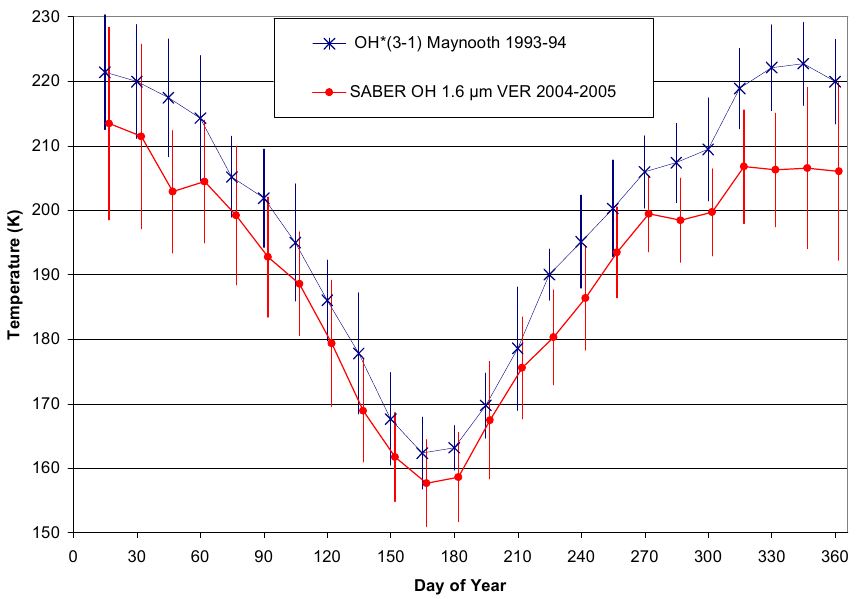
Fig. 10. OH*(3-1) rotational temperatures recorded at Maynooth in 1993 and 1994 together with OH-equivalent temperatures calculated from SABER temperature profiles at Maynooth in 2004 and 2005 using the SABER OH 1.6 µ m VER profile as the weighting function. The SABER points have been offset by +2 days on the x-axis to improve the clarity of the figure. The error bars are one standard deviation in all